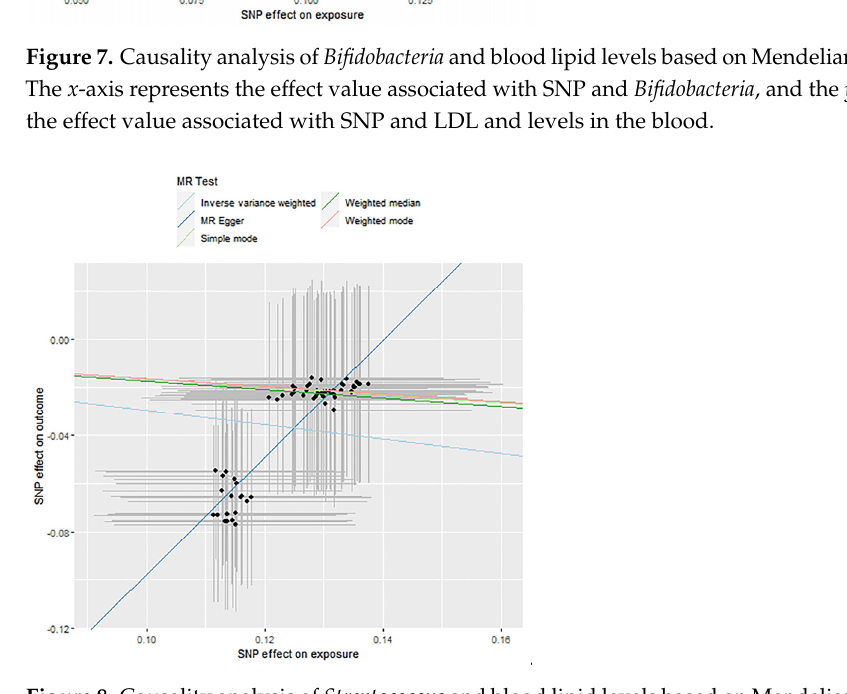
Figure 8. Causality analysis of Streptococcus and blood lipid levels based on Mendelian randomization. The x -axis represents the effect value associated with SNP and Streptococcus , and the y -axis represents the effect value associated with SNP and LDL levels in the blood.